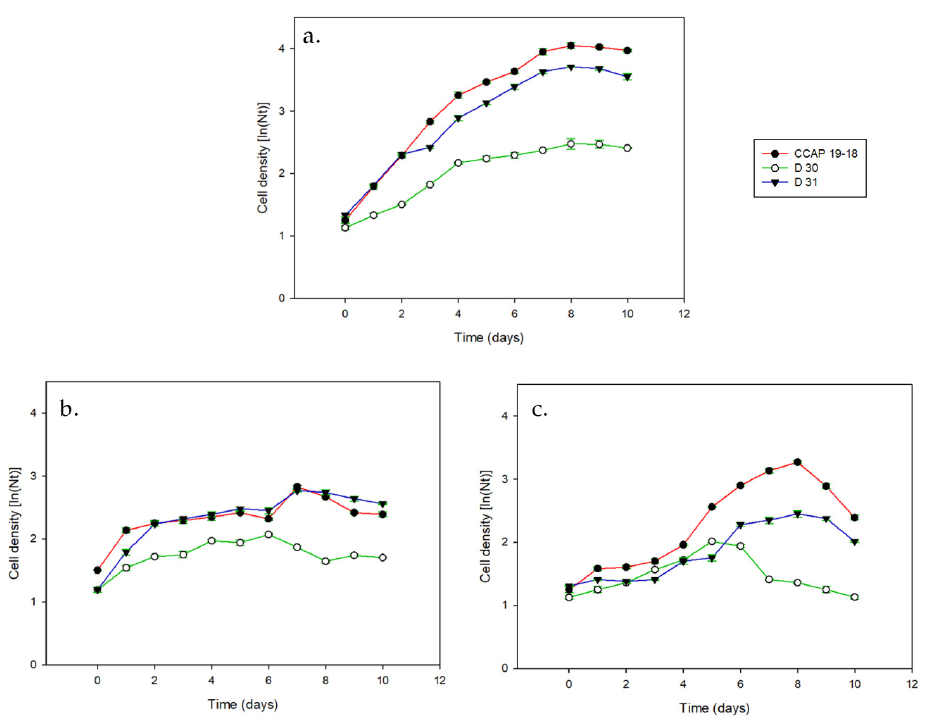
Figure 2. Growth curves of the studied strains cultivated in different conditions: ( a ) standard conditions, ( b ) nitrogen deprivation and ( c ) salinity stress. Cell yield is shown as cells/mL · 10 5 (SE, n = 3).